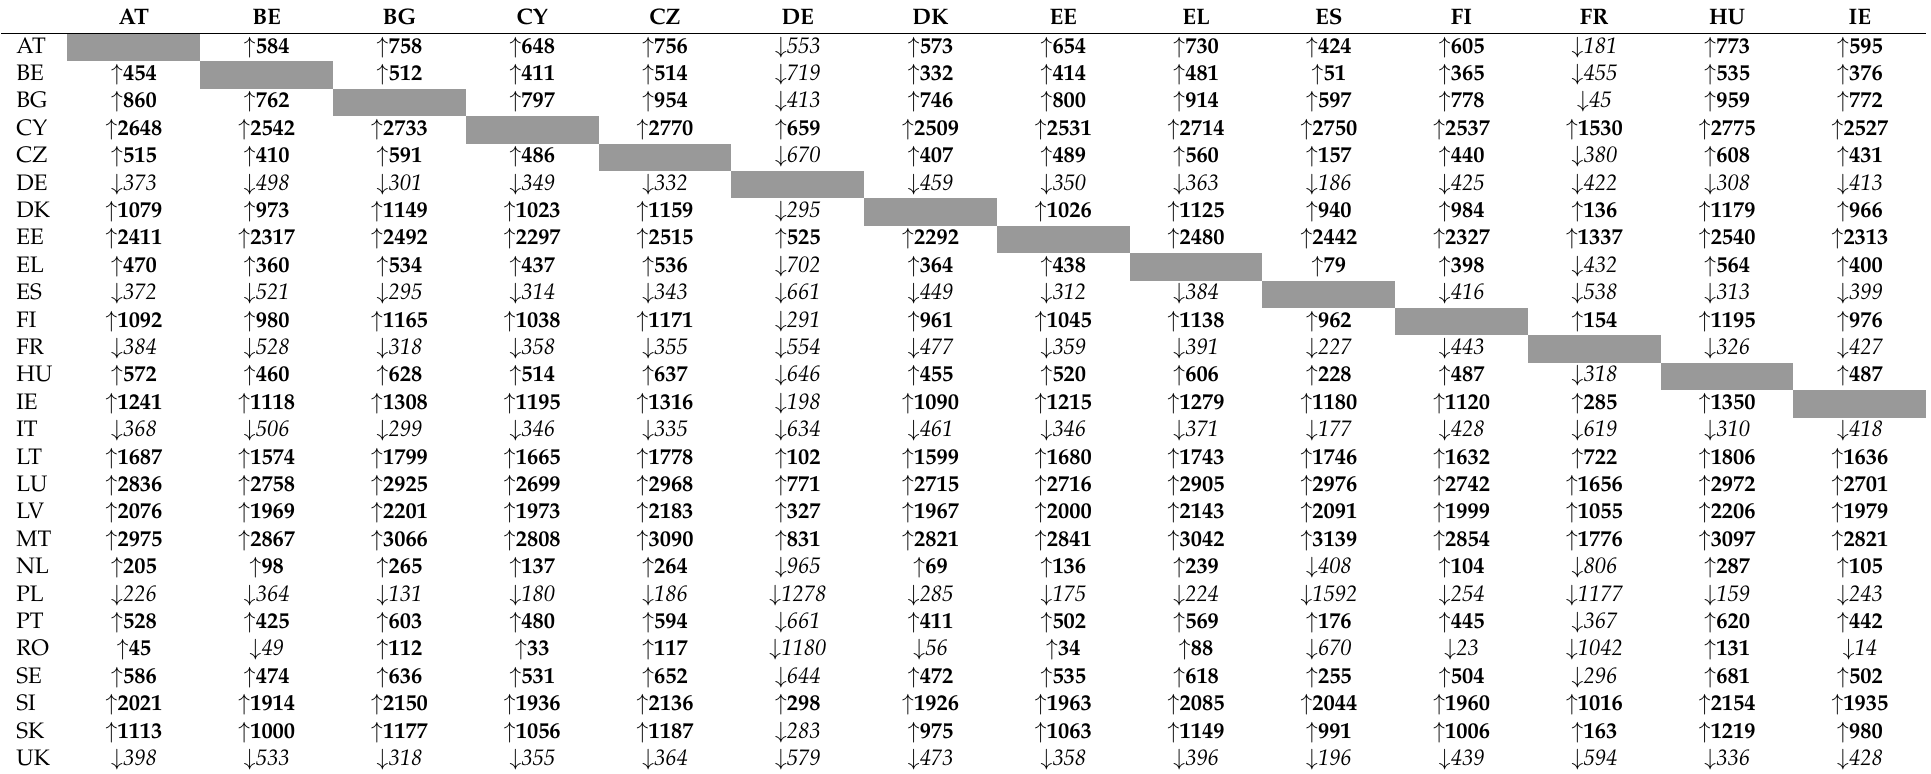
Table A3. The impact of any member state leaving before the accession of Croatia with populations for